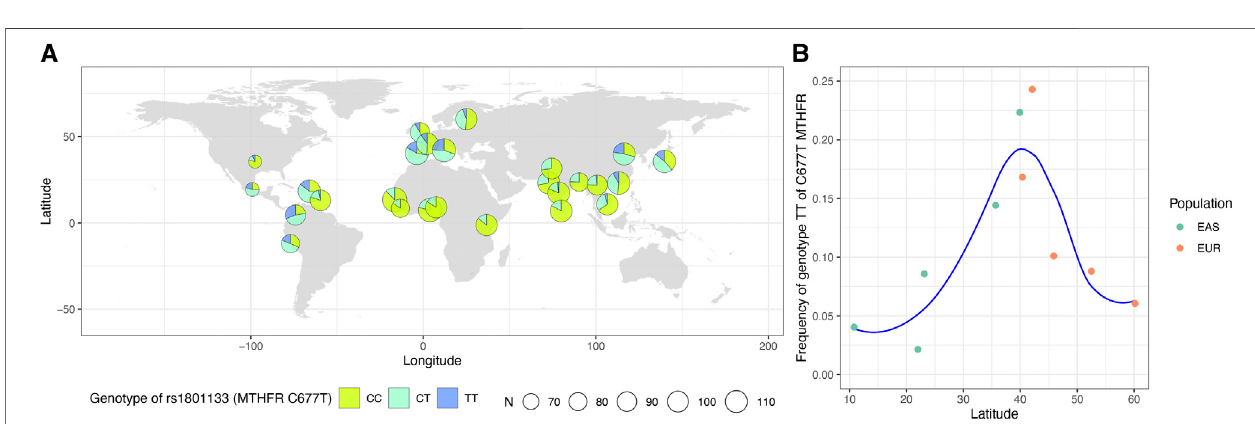
FIGURE3| Worldwideprevalencepatterns forgenotypesof MTHFR C677T (rs1801133). (A) Map displaying thegeospatialdistributionoftheprevalence patterns forgenotypesof MTHFR C677Tacrosstheworld.Themapwasdrawnbasedonthegenotypesof2,504subjectsobtainedfromthe1000GenomesProjectdatasetsfor this SNP. The pie denotes the sampling locations. (B) The frequency ofTT genotype of MTHFR C677T based on the genotypes of East Asians and Europeans obtained from the 1000 Genomes Project datasets and the corresponding latitude of each population. SNP, single-nucleotide polymorphism.